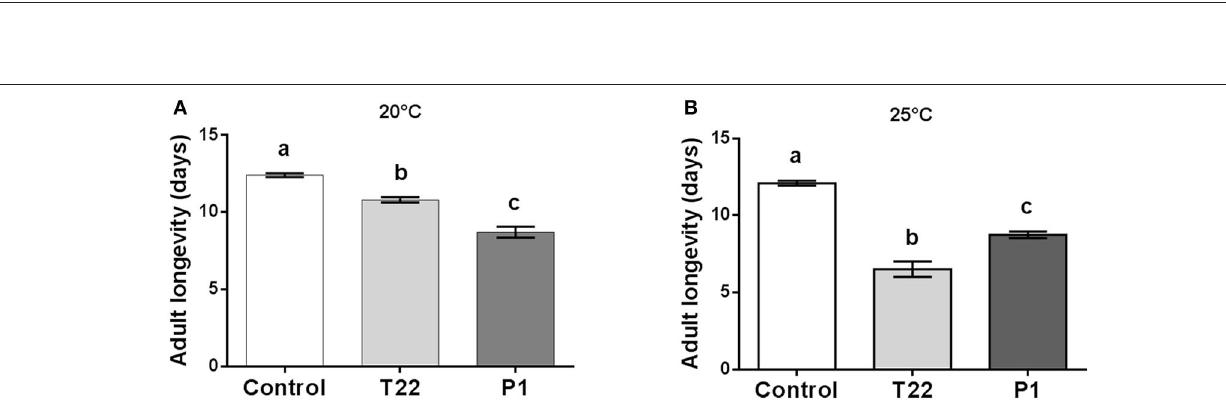
FIGURE 4 | Spodoptera littoralis adult longevity. Adults emerging from larvae fed on T22- and P1-tomato leaf disks showed a significantly lower longevity compared to Control adults. At 20 ◦ C, (A) P1-tomato had the highest negative impact on longevity, whereas at 25 ◦ C, the reverse was observed, with T22 showing a significantly higher negative impact on longevity. The values are means ± SD. Mean values denoted with different letters are significantly different (one-way ANOVA (A) or Kruskal–Wallis test (B) ( P < 0.05).